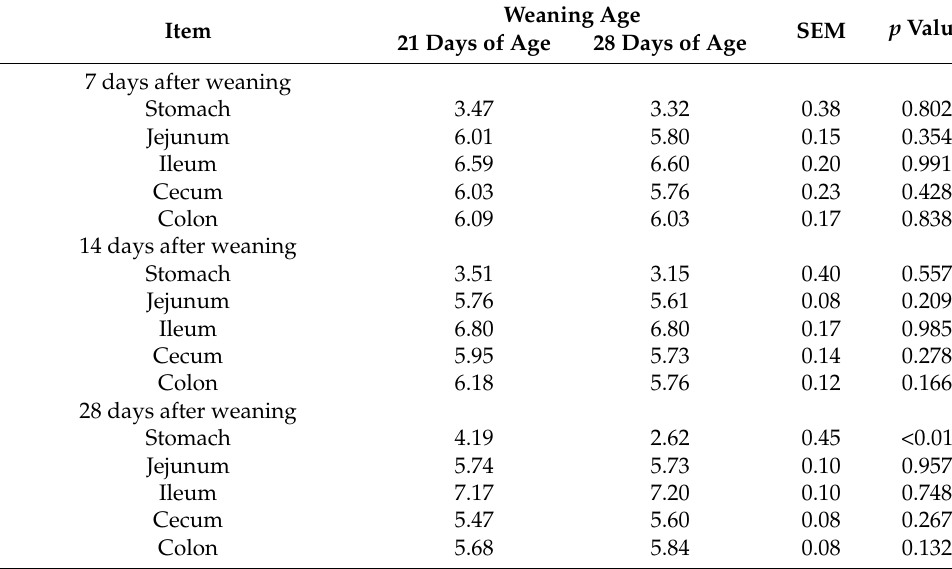
Table 4. Effect of weaning age on gastrointestinal pH of weaned pigs 1 .